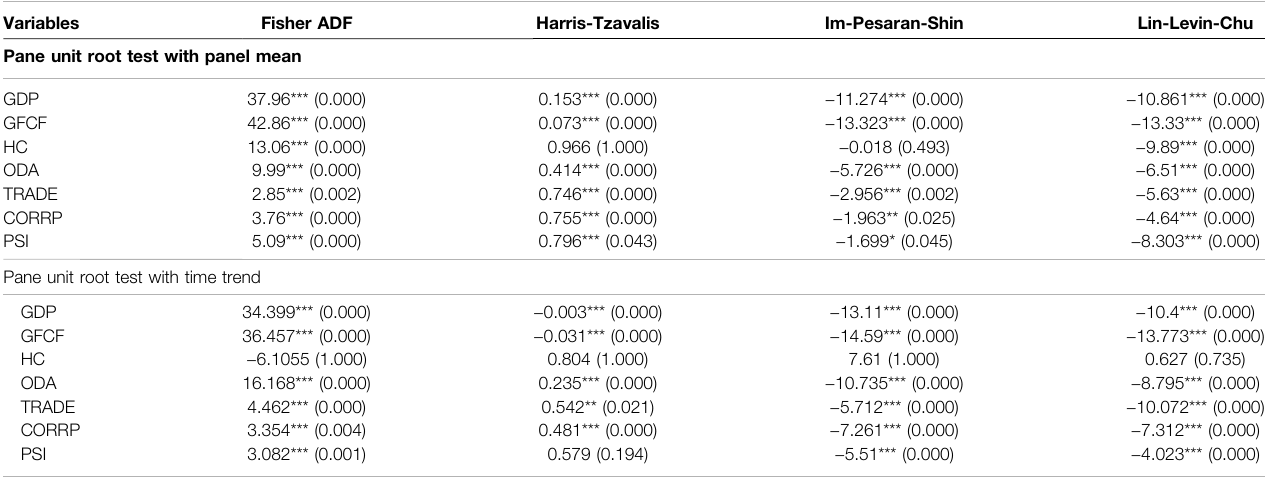
TABLE 6 | Results for pane unit root test with mean and trend.